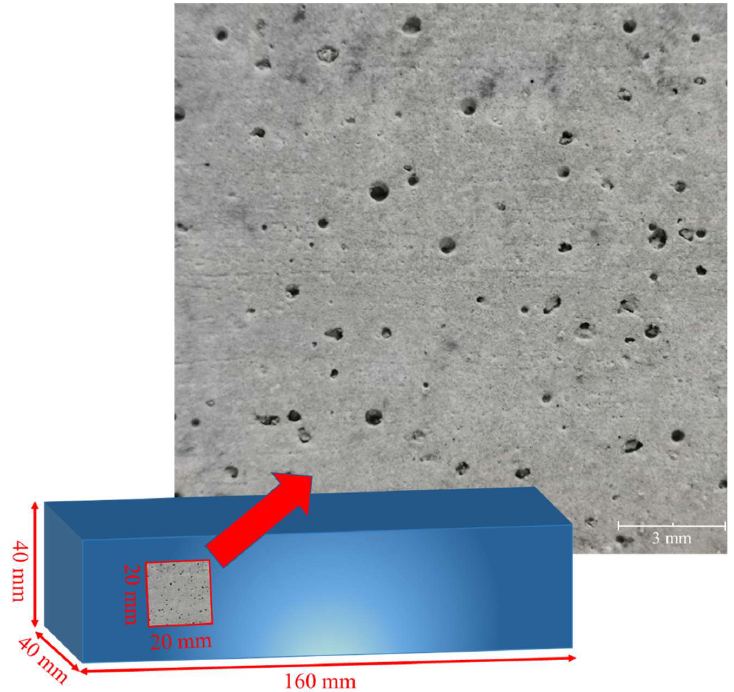
Figure 7. The large visible voids in the cement sample surface.